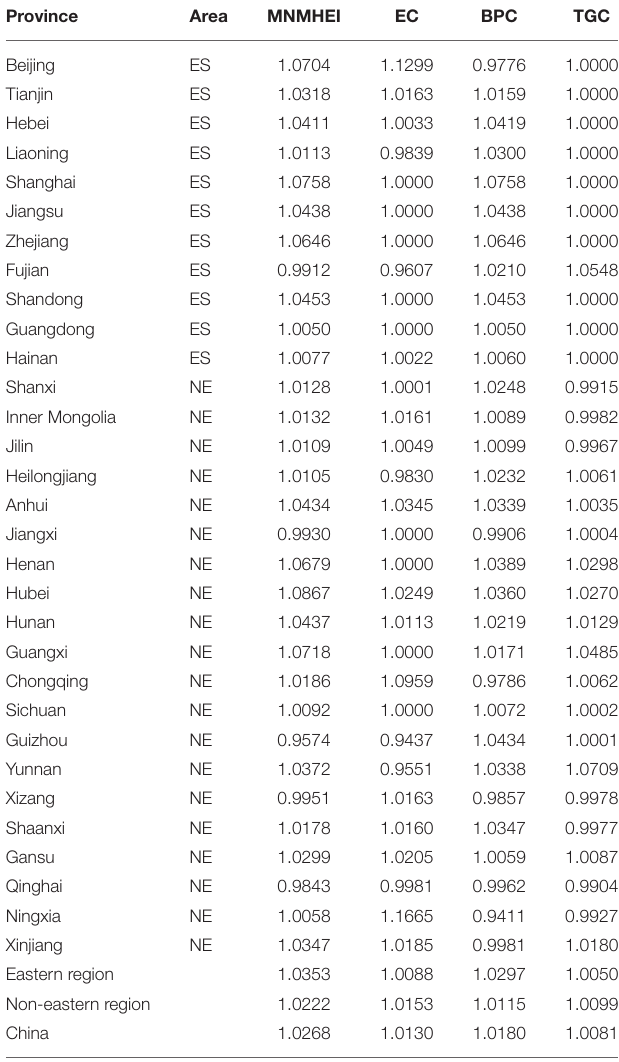
TABLE 2 | Average MNMHEI and the decomposition of provinces in